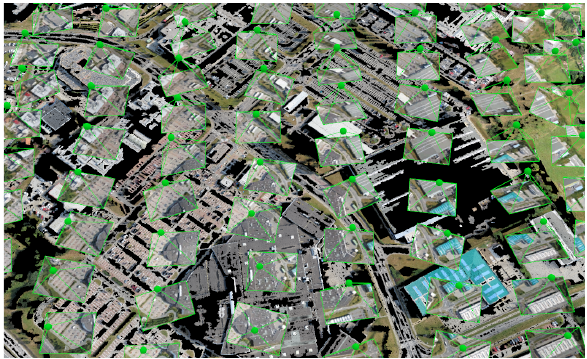
Figure 2: Poits of location and orientation of the camera while taking each picture of the scene